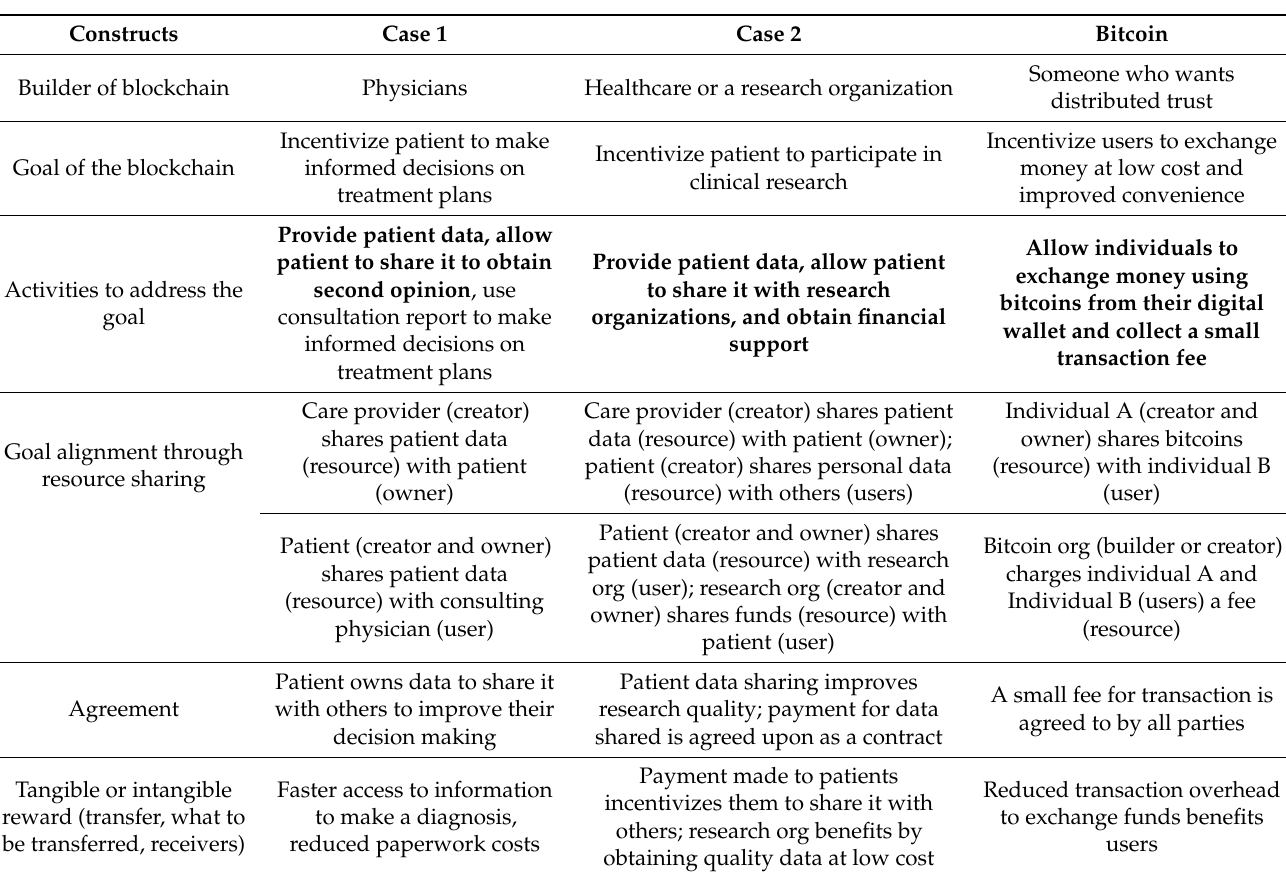
Table 1. Constructs as they are applied to each case.